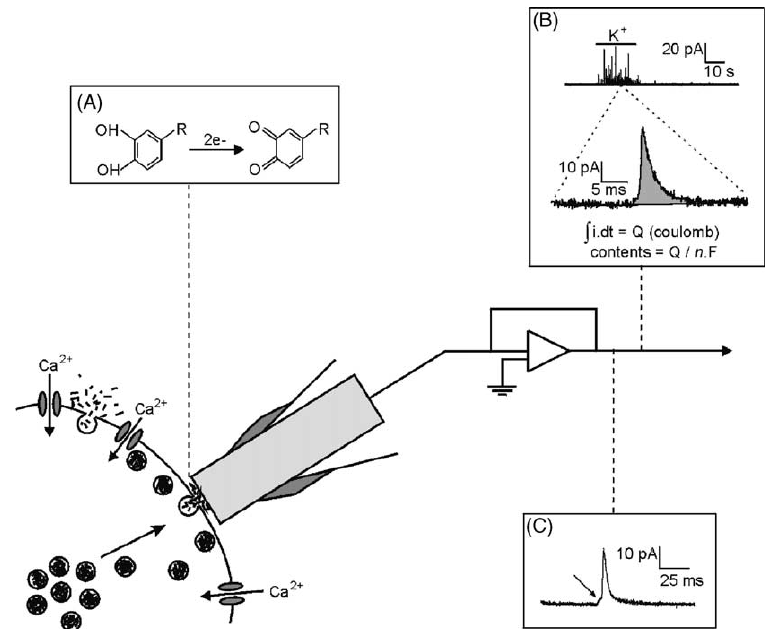
Figure 5. Detection of dopamine by amperometry. Experimental set-up for amperometric recording of vesicular catecholamine release from a secretory cell using a carbon fiber microelectrode; ( A ) schematic drawing of the electrochemical reaction; ( B ) amperometric recording from a PC12 cell; ( C ) example of an amperometric current transient on an expanded time scale